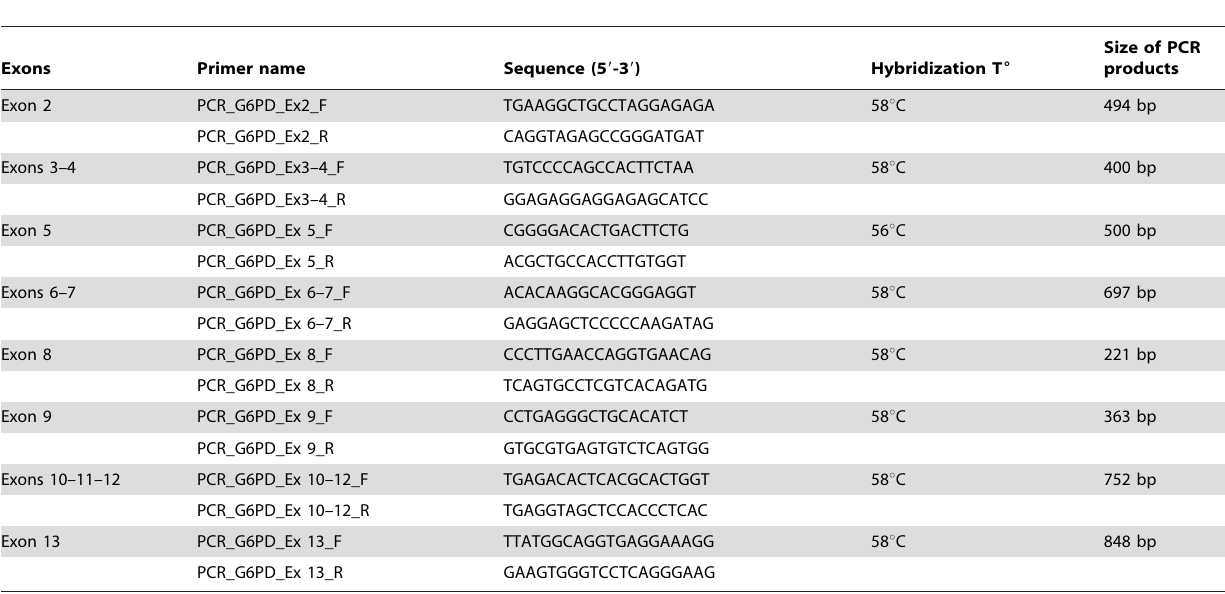
Table 1. Primers sequence, annealing temperatures and size of PCR products used to amplify and sequence exons of the G6PD